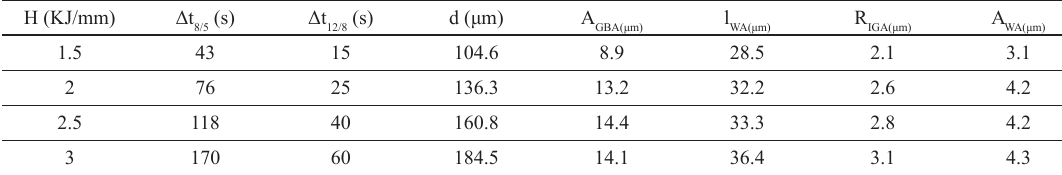
), average length of the WA laths (l GBA ). WA